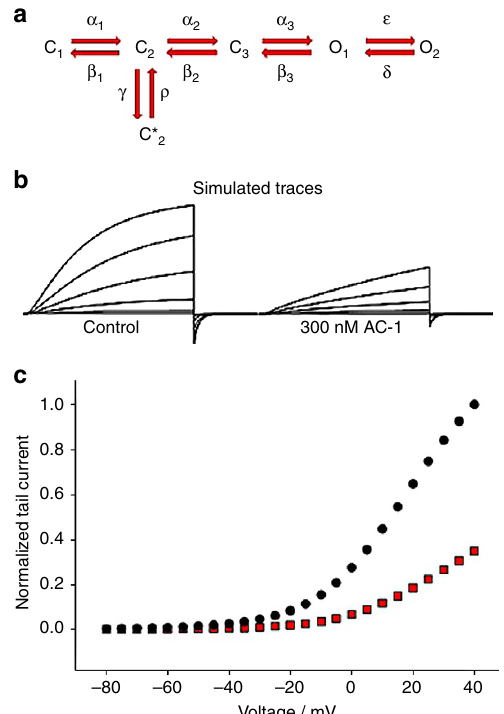
Figure 9 | Markov state modelling of AC-1 inhibition. Markov state modelling was used to simulate current traces under control and 300nM AC-1. The state model as indicated in a was used. The rate constants